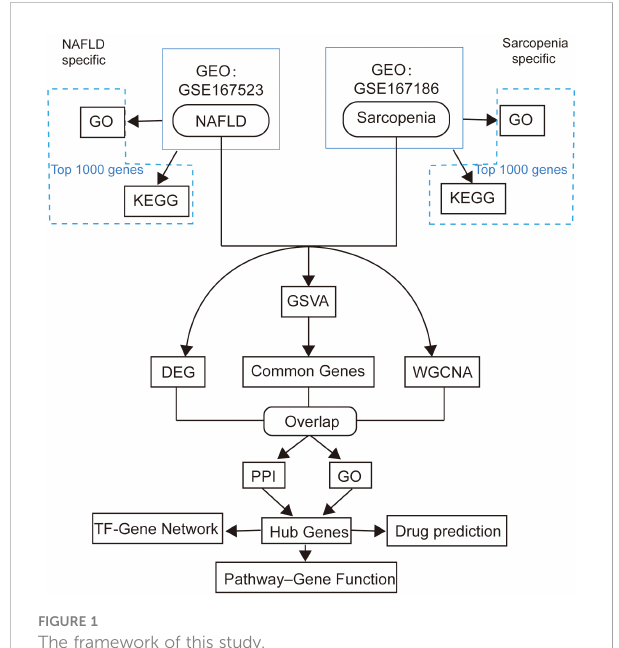
FIGURE 1 The framework of this